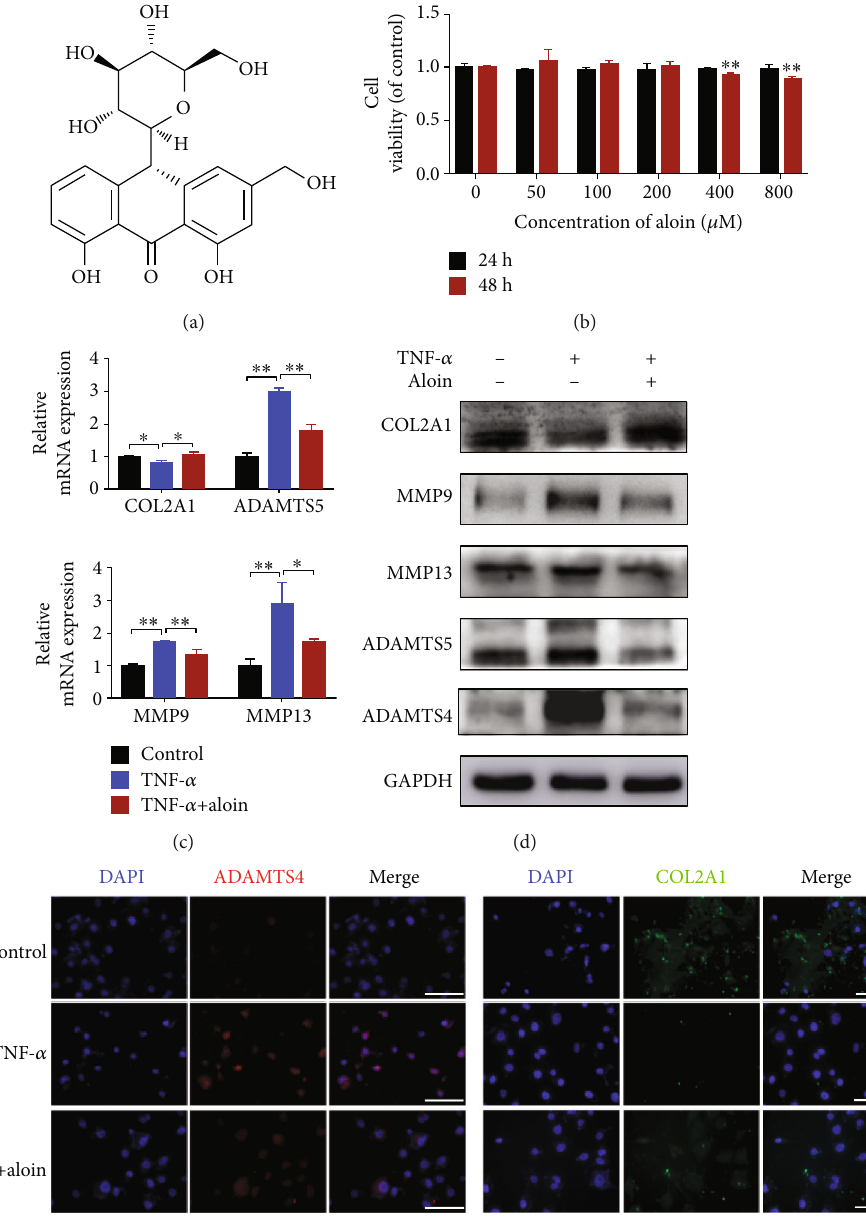
Figure 2: Aloin treatment enhances the anabolism and suppresses the catabolism in TNF- α -treated NPCs. (a) The chemical structure of aloin is shown (quoted from http://www.medchemexpress.cn/.) (b) Detection of aloin ’ s cytotoxic e ff ect on NPCs at various concentrations at 24 and 48h posttreatment using a CCK-8 assay (0, 50, 100, 200, 400, and 800 μ M). (c) The mRNA expression levels of COL2A1 , ADAMTS5 , MMP9 , and MMP13 in the di ff erent groups were detected by qPCR. (d) Protein expression of COL2A1, ADAMTS5, MMP9, and MMP13 was detected by western blotting in the di ff erent groups. (e) Both ADAMTS4 and COL2A1 were detected by immuno fl uorescence staining. DAPI was used to stain for the nuclei. Images (magni fi cation: × 400, scale bar: 50 μ m). In this (c – e), aloin was used at the concentration of 200 μ M, while TNF- α was at the concentration of 10ng/ml. ∗ P < 0 : 05 , ∗∗ P < 0 : 01